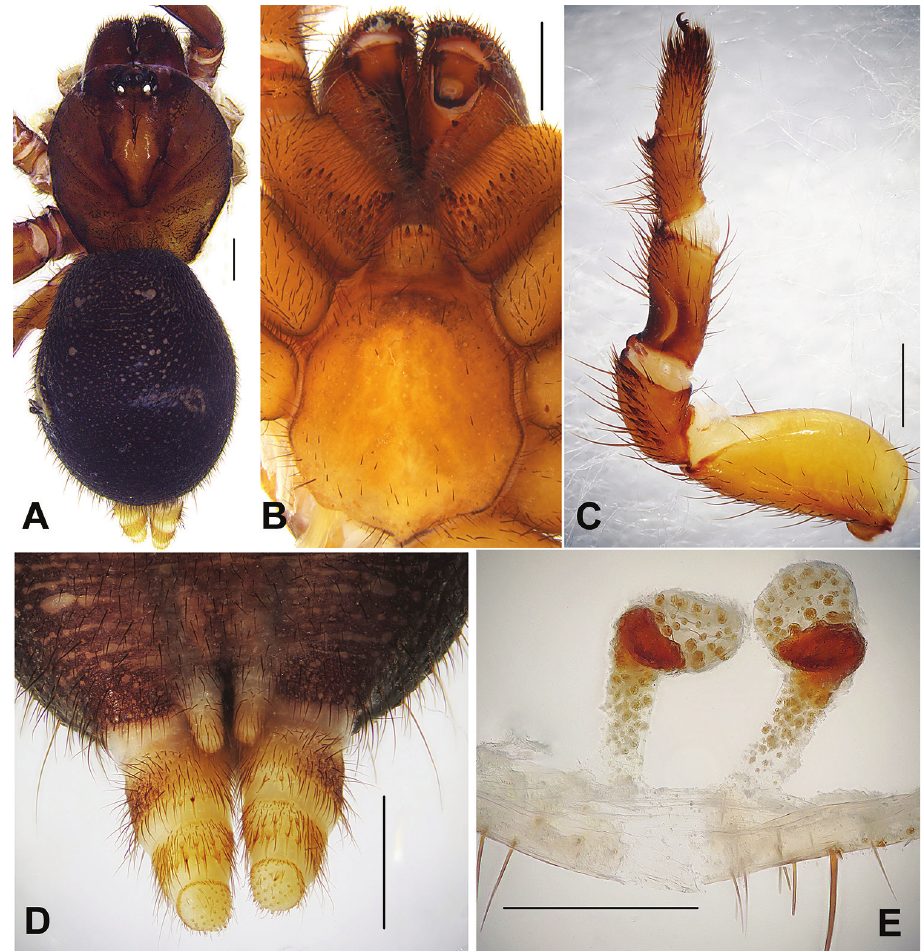
Figure 1. A General somatic morphology of Conothele baiyunensis Xu, Xu & Liu, sp. n. (female, XUC- 2014-062) B chelicerae, labium, coxae of palp and sternum, ventral view C left leg III, prolateral view D spinnerets, ventral view E female genitalia, dorsal view. Scale bars: A–D 1 mm, E 0.5 mm.